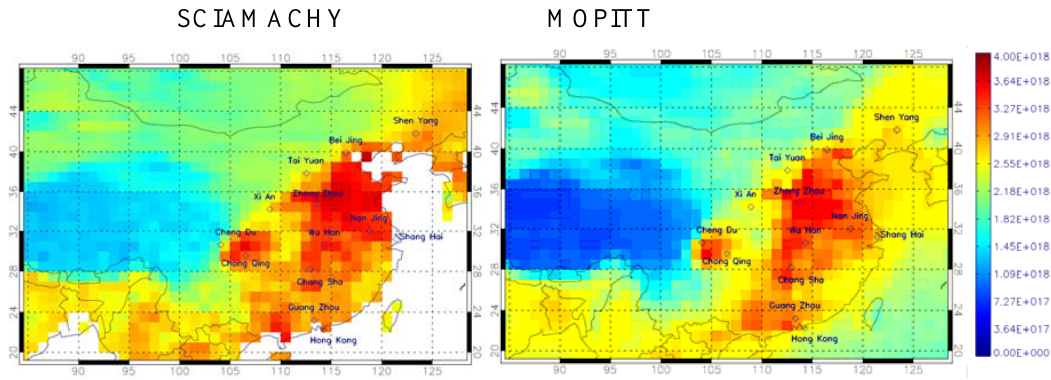
Fig 9. Comparison of the spatial distribution of the CO VCD (average 2003 to 2005) over China derived from SCIAMACHY (left) and MOPITT version 4 (right).